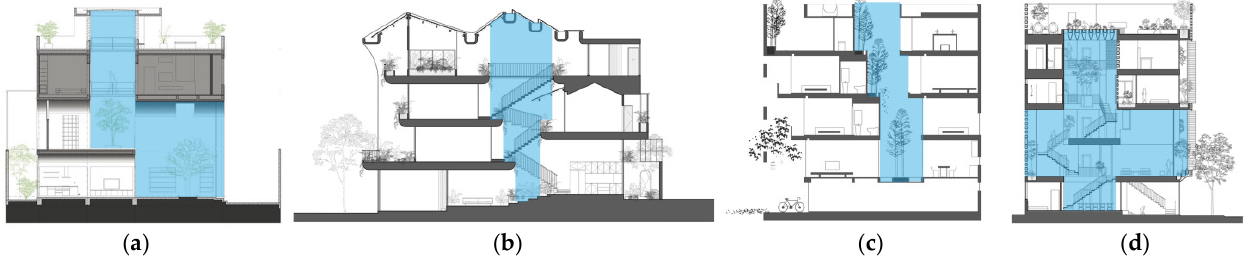
Figure 1. Different sectional shapes of courtyards in modern LSH in Vietnam: ( a ) VOM House [37]; ( b ) Gardening terrace house [38]; ( c ) A house in trees [39]; ( d ) Tropical Cave House [40]. (From left to right).